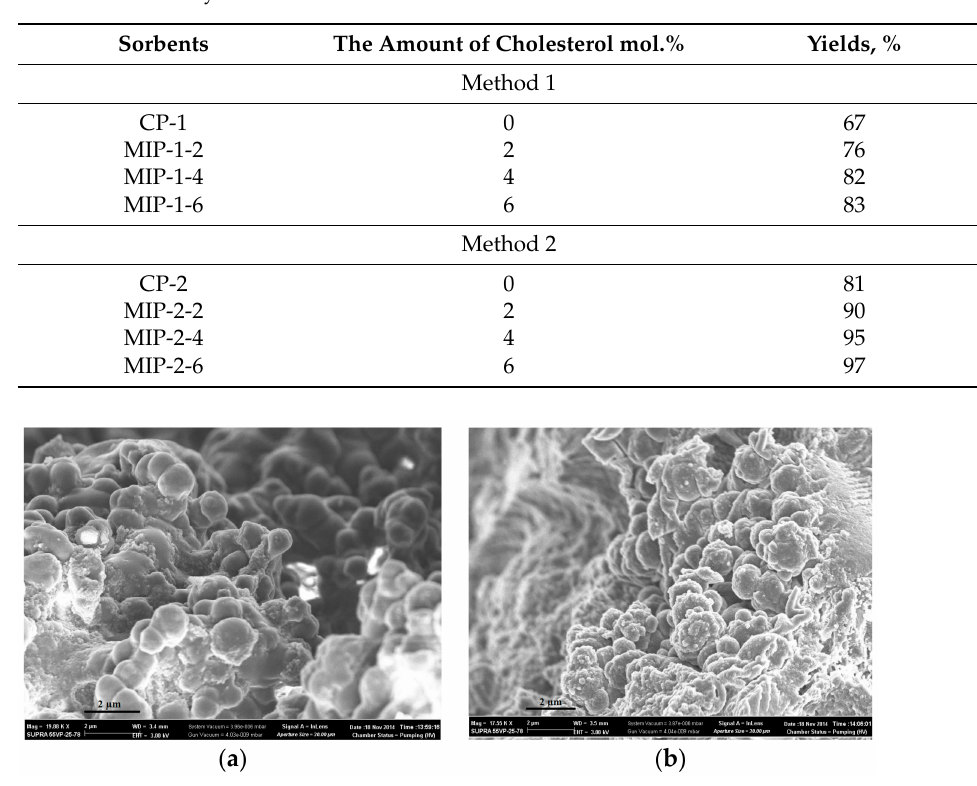
Figure 3. SEM of the surfaces of sorbents: network CP-1 ( a ) and network MIP-1-6 ( b ).